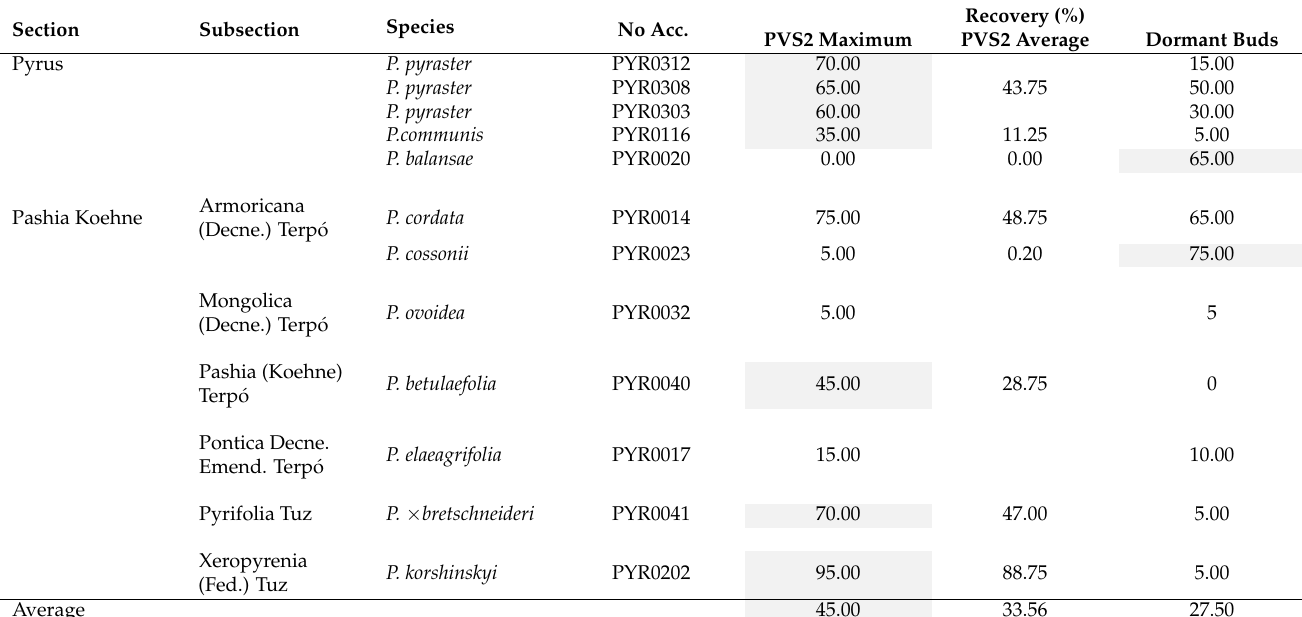
Table 4. Comparison between PVS2 vitrification of shoot tips and dormant bud techniques depending on Pyru s species. Shown are the regeneration values for the maximum and the mean value for PVS2 as well as the regeneration value for the dormant buds